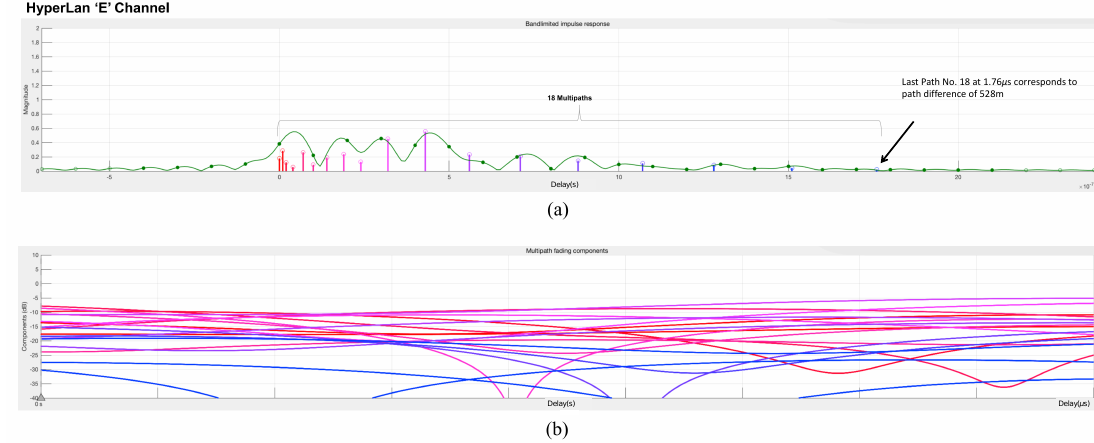
Figure 11. Multipath components of the HIPERLAN-E channel: ( a ) Bandlimited impulse response. ( b ) Multipath fading components after 850 µ